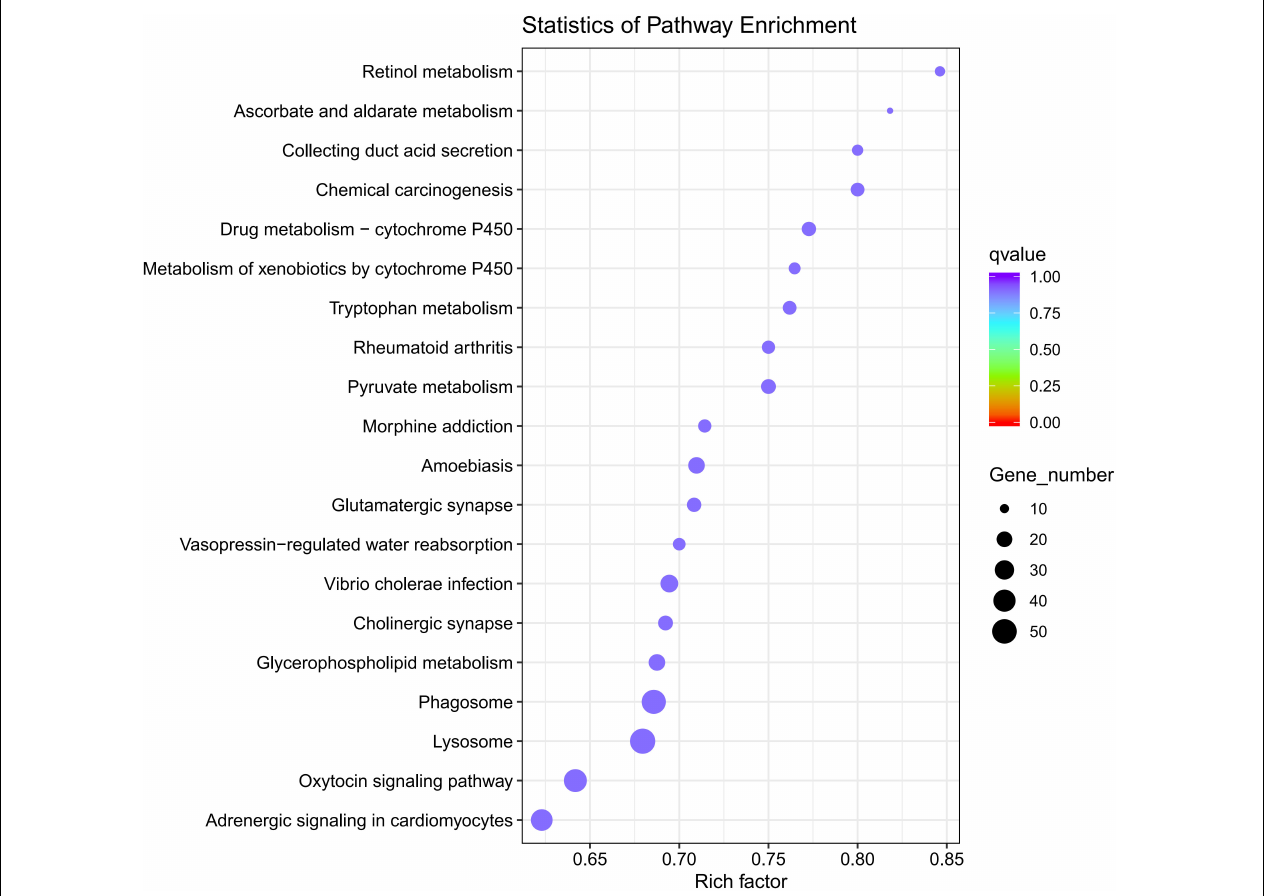
FIGURE 6 | DEGs-enriched Kyoto Encyclopedia of genes and genomes (KEGG) pathways scatter diagram ( q -value is the p -value corrected by multiple hypothesis test, the value range of q -value is [0,1]).